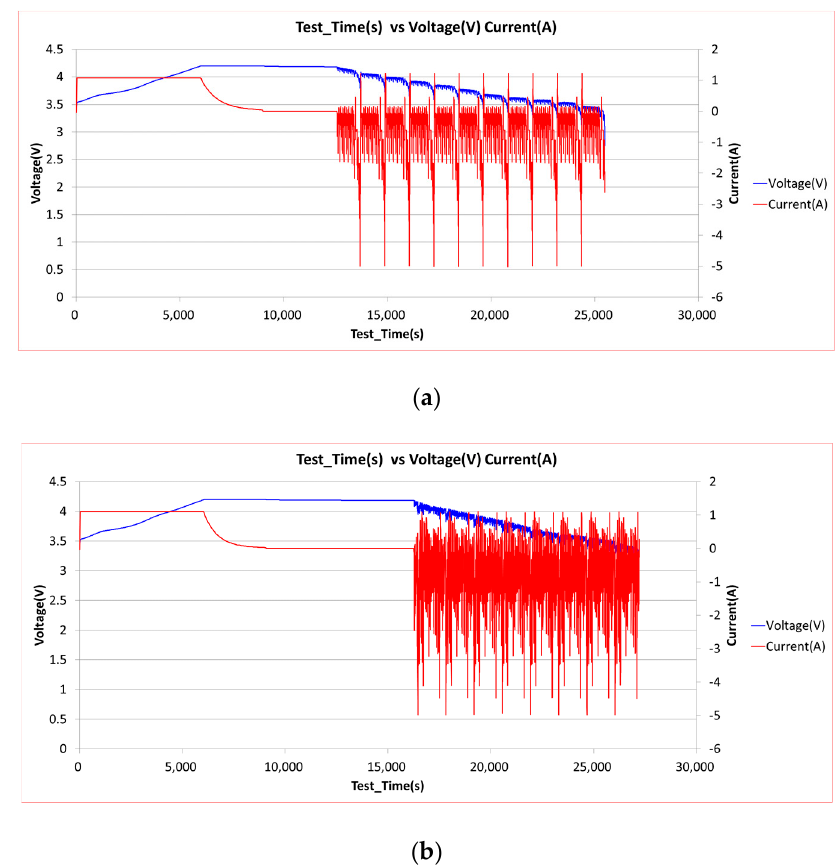
Figure 8. Power load profile: ( a ) New European Driving Cycle (NEDC) working conditions; ( b ) Urban Dynamo-meter Driving Schedule (UDDS) working conditions.